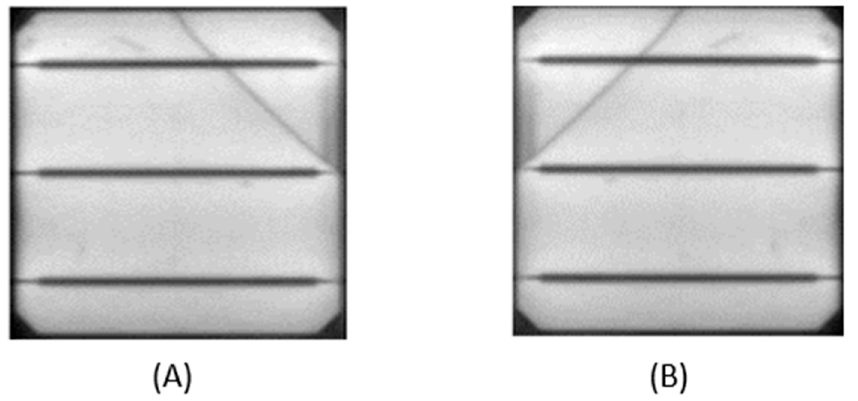
Figure 3. Horizontal flipping ( A ) input ( B ) output.